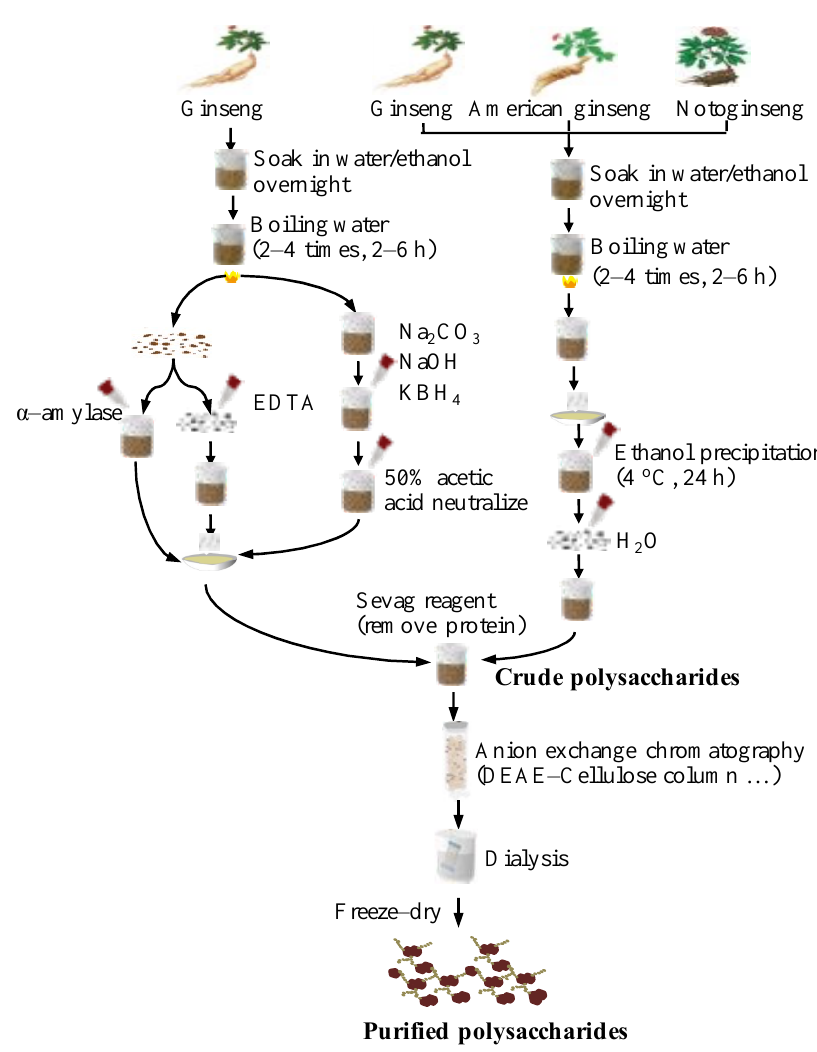
Figure 1. Schematic procedures for extraction and purification of the polysaccharides from three Panax species.